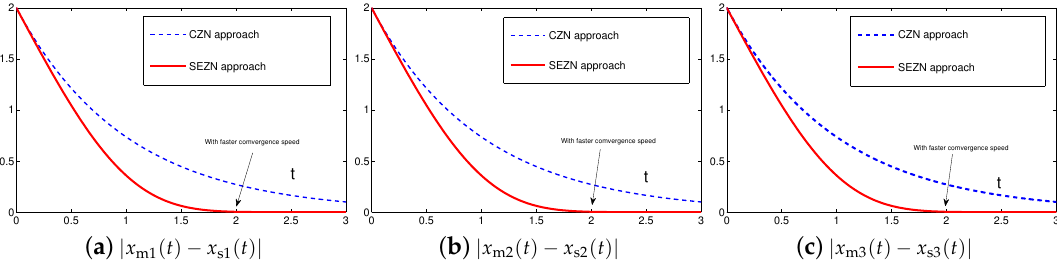
Figure 11. Absolute errors between two identical autonomous chaotic systems (27) and (28) equipped with controller (7) via the CZN approach in comparison with controller (6) via the proposed SEZN approach.